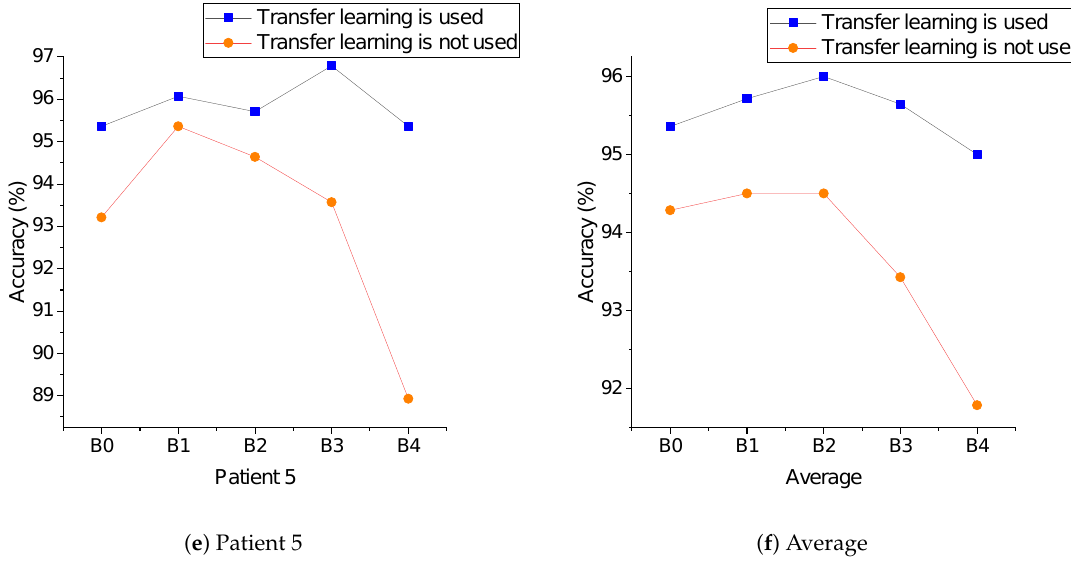
Figure 6. Transfer learning. The EfficientNet trained on the ImageNet dataset. The network was then trained using the seizure dataset to obtain the final network weights.